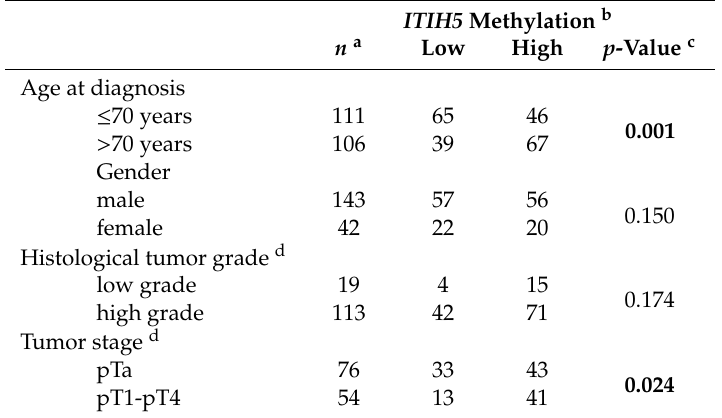
Table 2. Clinico-pathological parameters in relation to ITIH5 methylation in training cohort